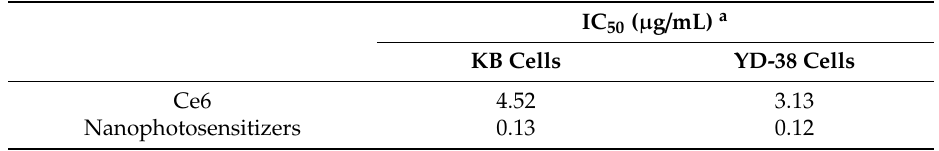
Figure 6. ( a ) Fluorescence microscopic observations of KB cells treated with Ce6 alone or FA–PEG 3500 -ss-Ce6tri copolymer nanophotosensitizers. FA was pretreated to the cells to block folate receptor; ( b ) Ce6 uptake ratio; ( c ) ROS production; ( d ) phototoxicity. Competition assay for folate receptor-sensitivity of KB cells, cells were exposed to 5-mM folic acid for 1 h and, after that, cells were washed Ce6 alone or nanophotosensitizers (2 µ g / mL as a Ce6) were treated to cells. Following procedures was similar to those of Figures 4 and 5. Bar = 40 µ m. Table 2. IC 50 values of Ce6 and